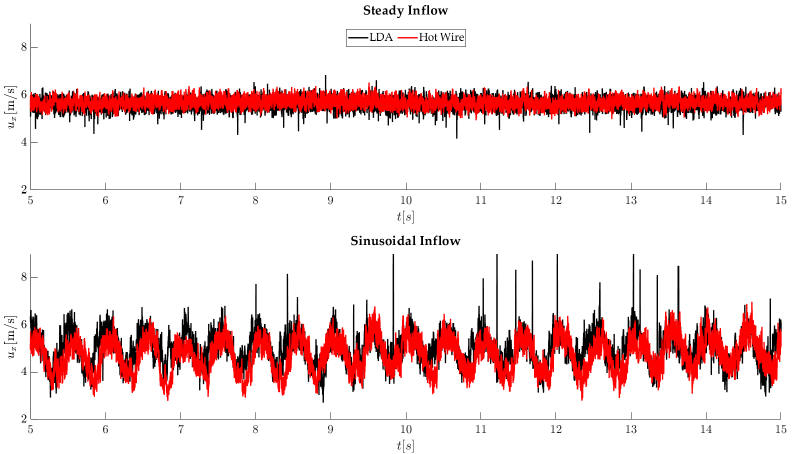
Figure 8. Wind flow profiles.